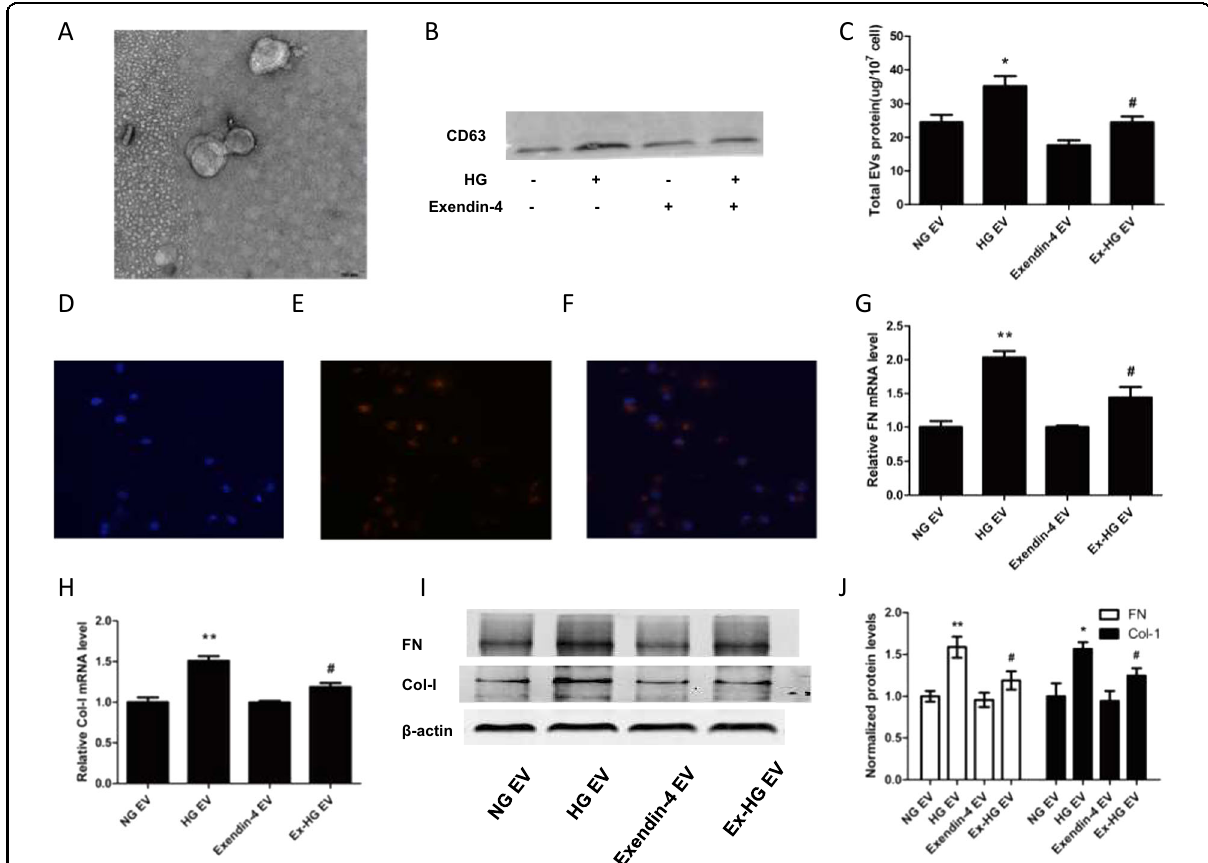
Fig. 2 Treatment of HK-2 cells with Ex-HG group-derived EVs induced less fi brosis in recipient cells than treatment with HG group-derived EVs. a EVs from HK-2 cells identi fi ed using TEM. b Western blot of CD63 expression of in EVs from 5 × 10 7 cells. c Total EV protein from the NG group, HG group, exendin-4 group, and Ex-HG group. d – f Co-culture of EVs with recipient cells. EVs from donor cells were labeled with Dil-C18, and recipient cells were labeled with DAPI; red represents Dil-C18, and blue represents nuclear DNA. g , h Relative expression of FN and Col-I in HK-2 cells after incubation with EVs derived from NG, HG, exendin-4, and Ex-HG groups for 48 h. i , j The FN and Col-I expression in HK-2 cells after incubation with EVs derived from NG, HG, exendin-4, and Ex-HG groups for 48 h was analyzed by western blot (* P < 0.05 and ** P < 0.01 versus the NG EV group; # P < 0.05 versus the HG EV